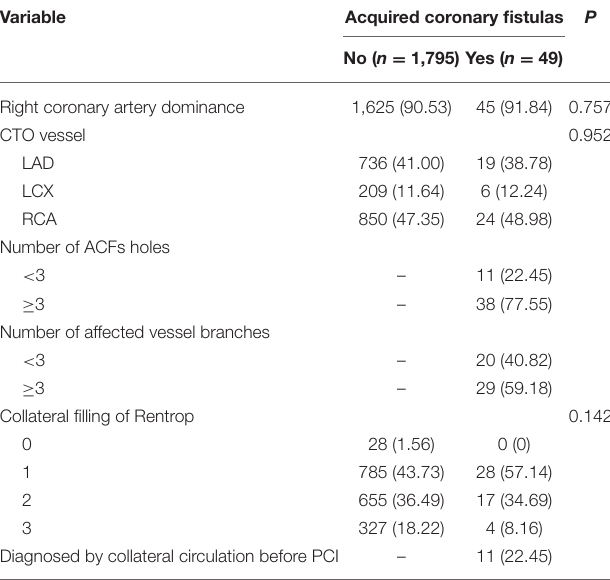
TABLE 2 | Angiographic characteristics of ACFs in